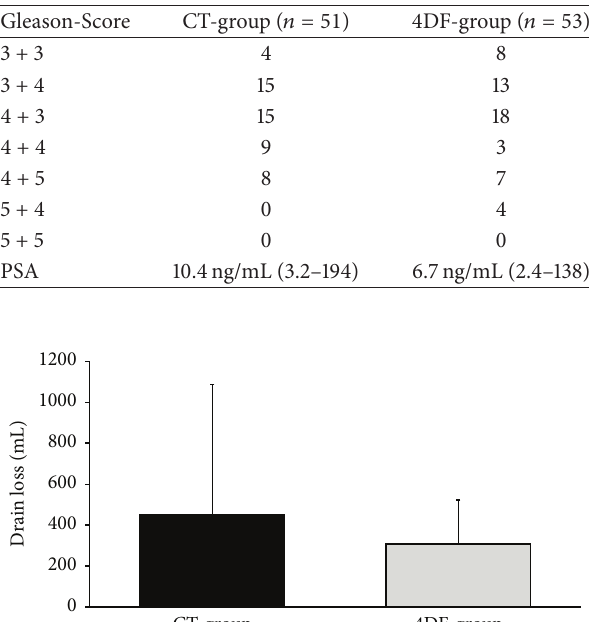
Table 2: Gleason-Scores and median PSA-values.